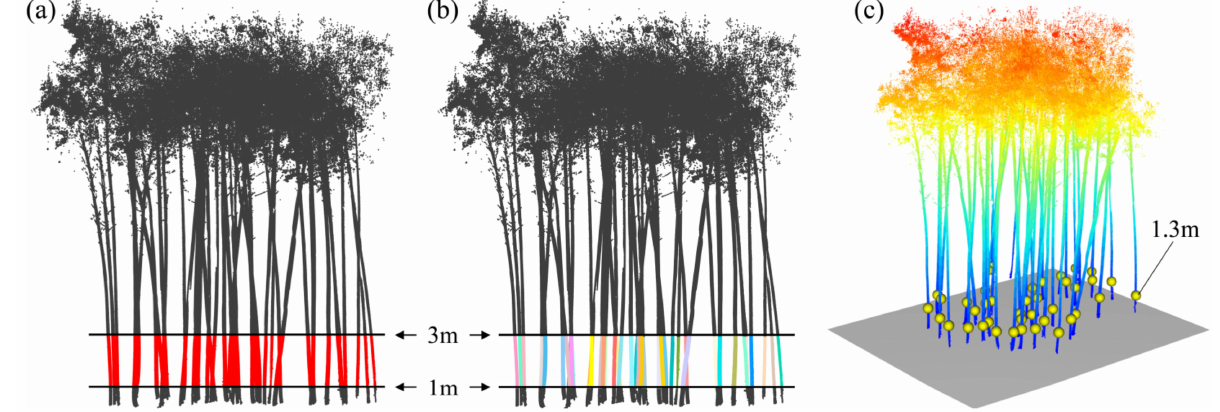
Figure 3. Process of generating seed points: ( a ) selected horizontal strip; ( b ) identified positions of individual Moso bamboos; ( c ) generated seed points at the culm height of 1.3